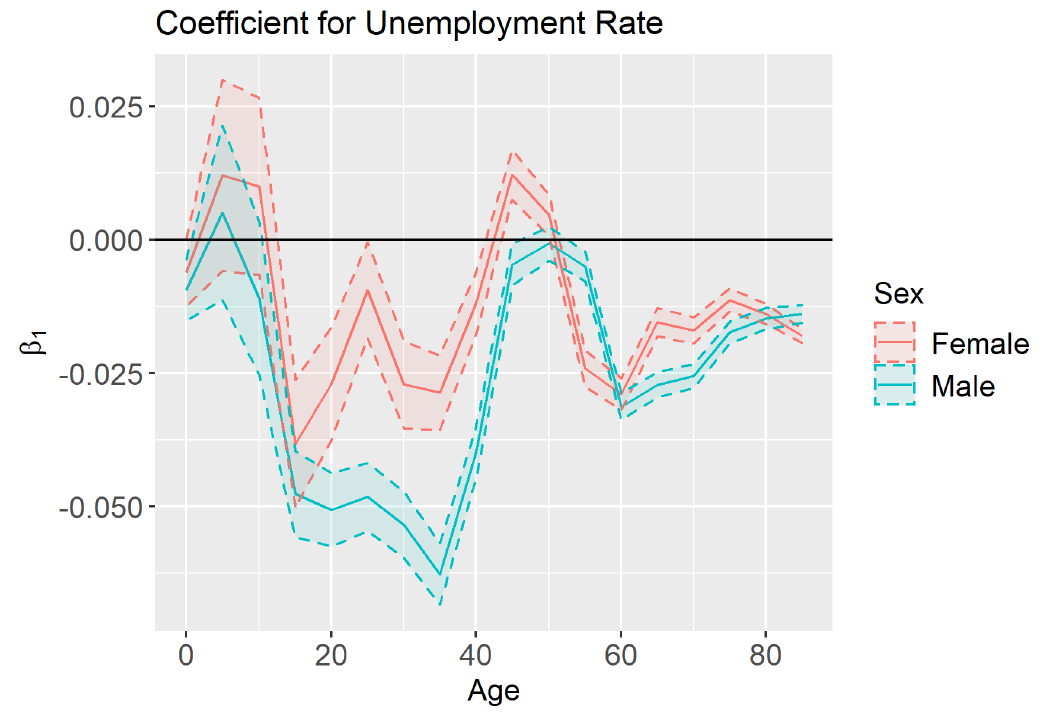
Figure 7. Estimates and 95% credible intervals for β 1 (effect of county-level unemployment rate on mortality) by sex and